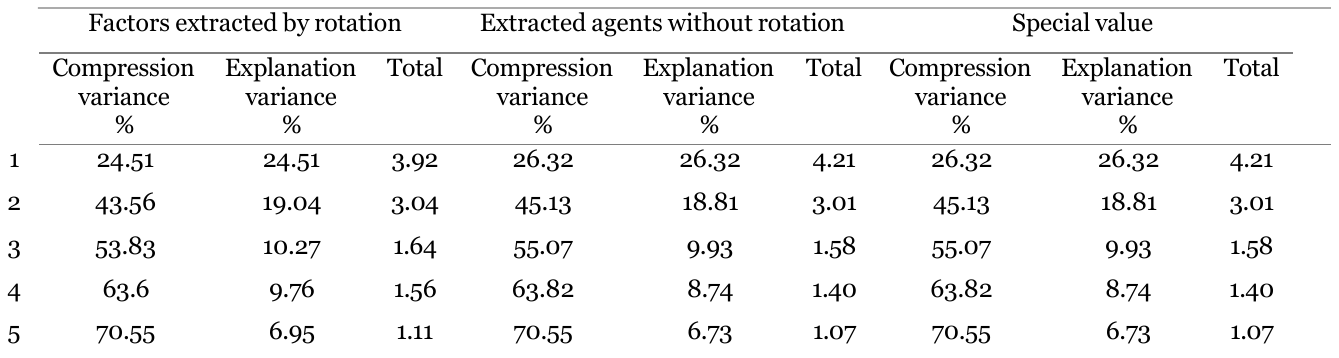
Primary and Extractive Exploration of Exploratory Agent Analysis of the Peer Review Checklist Factors extracted by rotation Extracted agents without rotation Special value